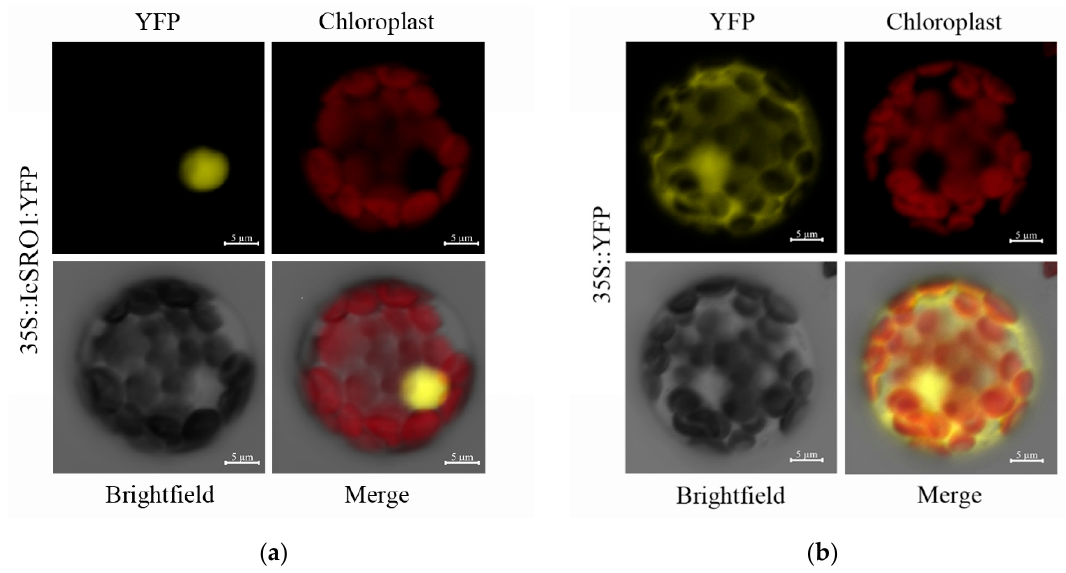
Figure 4. Subcellular localization of IcSRO1 protein. IcSRO1-YFP fusion protein was localized in nucleus of Arabidopsis mesophyll protoplast ( a ), while YFP was distributed throughout the entire protoplast cell ( b ). The yellow indicates yellow fluorescent, and the red represents chloroplast autofluorescence. Scale bars = 5 μ m.